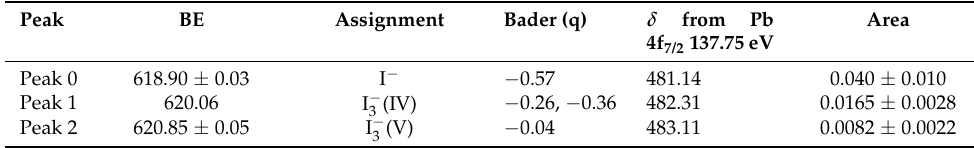
Table 3. Three-peak model of I 3d 5/2 difference spectra for high iodine samples. The position of peak 1 was fixed to 620.06 eV. The FWHM of each peak was fixed to 1.0 eV. The peaks are assigned to iodine chemical environments, and associated Bader charges of DFT structures are included for reference. Reported error values are correlative error from fits.